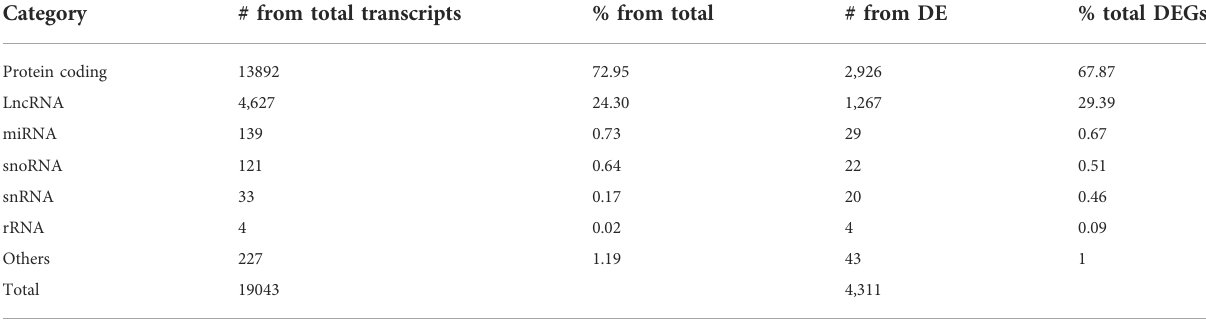
TABLE 1 Number and percentage of the different classes of annotated transcripts. Columns depict the number (#) of transcripts either from total mapped transcripts or from differentially expressed (DE) from all Leishmania -infected macrophages and the percentage (%) for each category. LncRNA, long noncoding; miRNA, microRNA; snoRNA, small nucleolar RNA; snRNA, small nuclear RNA; rRNA, ribosomal RNA.